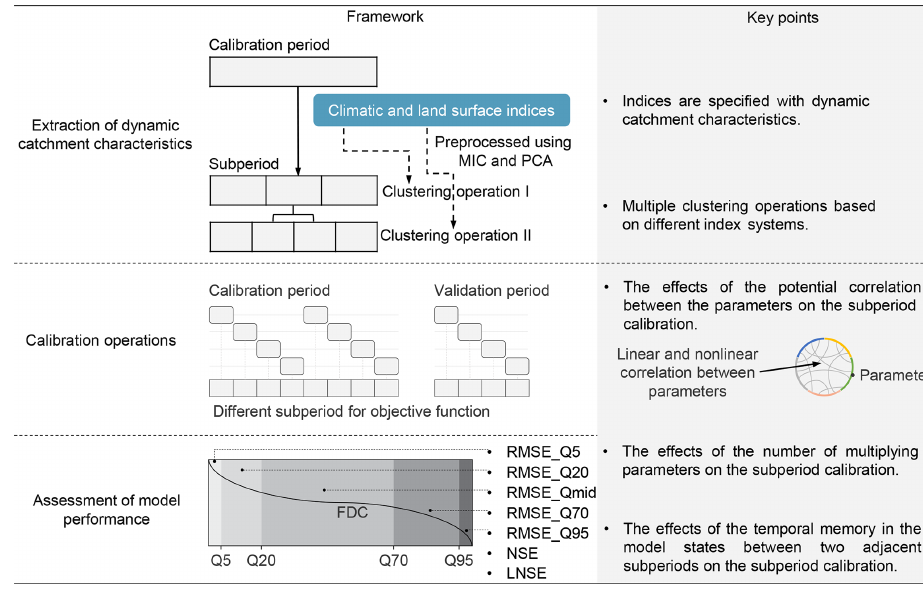
Figure 2. The developed framework for seasonal dynamics of hydrological model